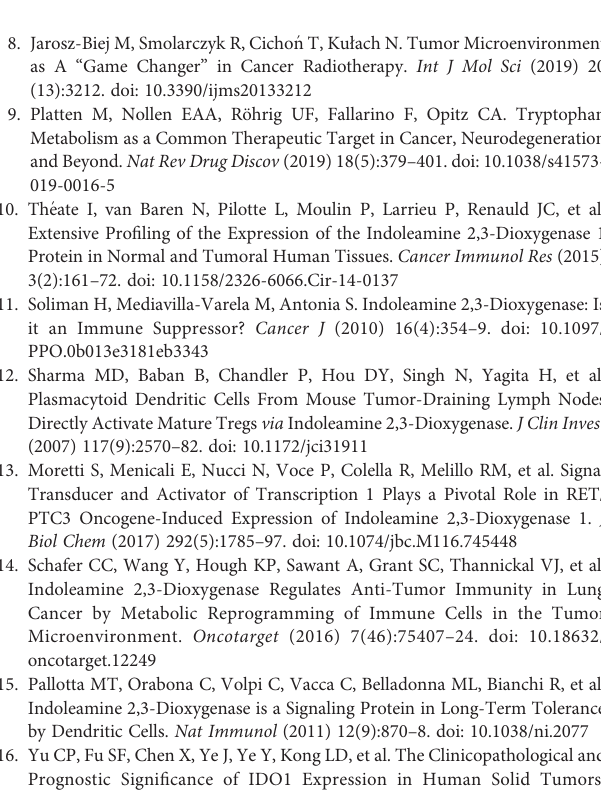
Supplementary Figure 1 | Response rate in patients with low and high pre-RAI K/T ratio groups. Supplementary Figure 2 | Representative images of CD3 + and CD8 + tumor- in fi ltrating lymphocytes in two different with DTC. (patient 1: non-responder;patient 2:responder). Scale bar, 50 m m. Supplementary Figure 3 | Response rate in patients with low and high post/pre- kynurenine